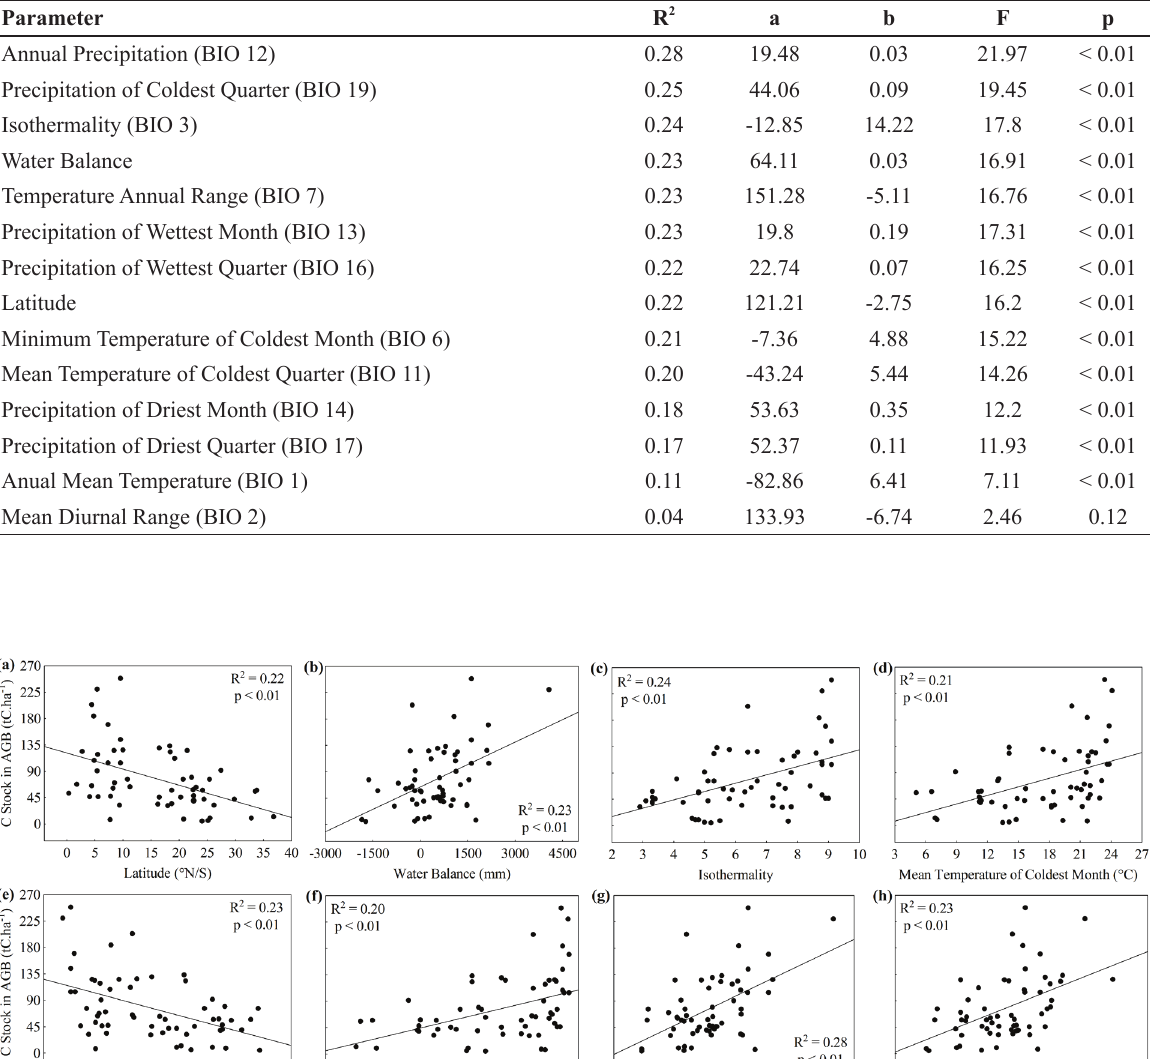
Results of the regression tests between climatic parameters and carbon stock in the aboveground biomass.